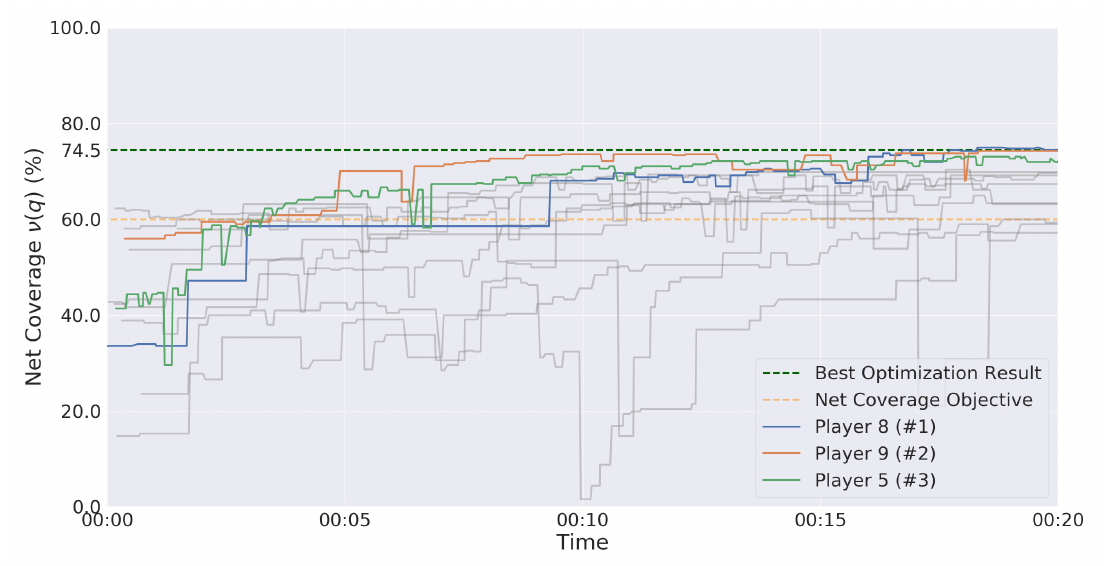
Figure 9. Temporal course of achieved net coverages per player.